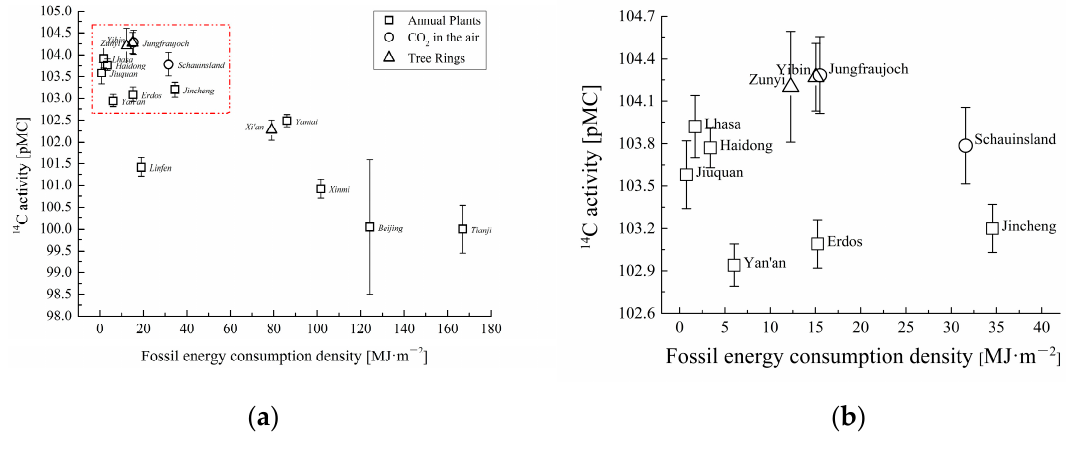
Figure 4. ( a ) Fossil energy consumption density of multiple cities in China, 2010 and 14 C activity of plant samples representing atmosphere in these cities; ( b ) the zoom graph of the defined part, FCD from 0 to 40 MJ · m − 2 and 14 C activity from 102.6 to 104.7 pMC.